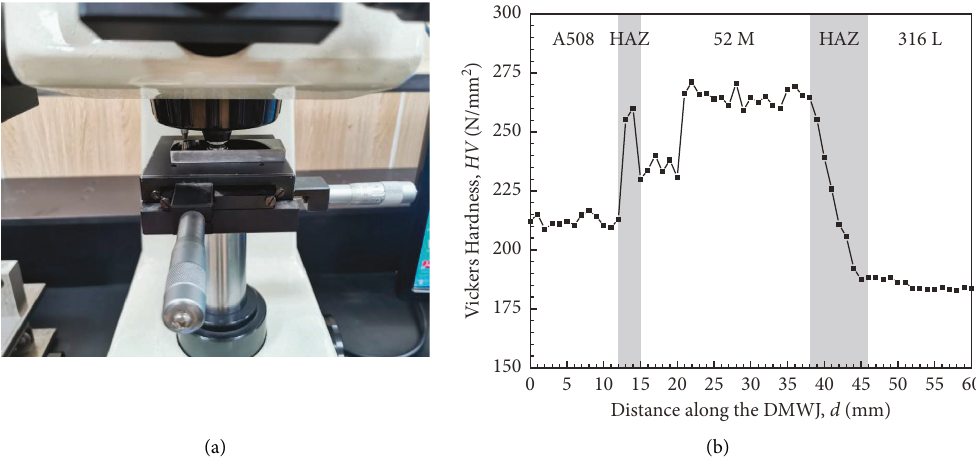
Figure 2: Vickers hardness experiment. (a) Experimental process. (b) Vickers hardness HV distribution of the DMWJ sample.